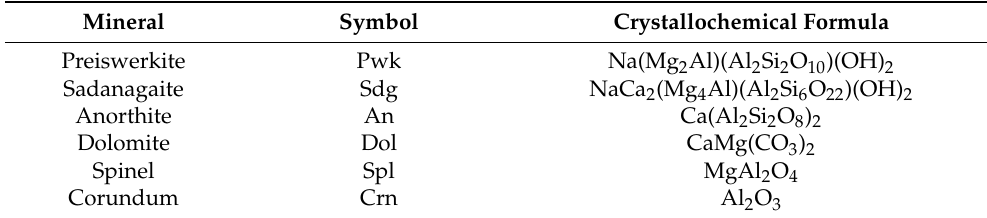
Table 5. Theoretical compositions of minerals (solid-solution components) adopted for calculating chemical reaction equations.